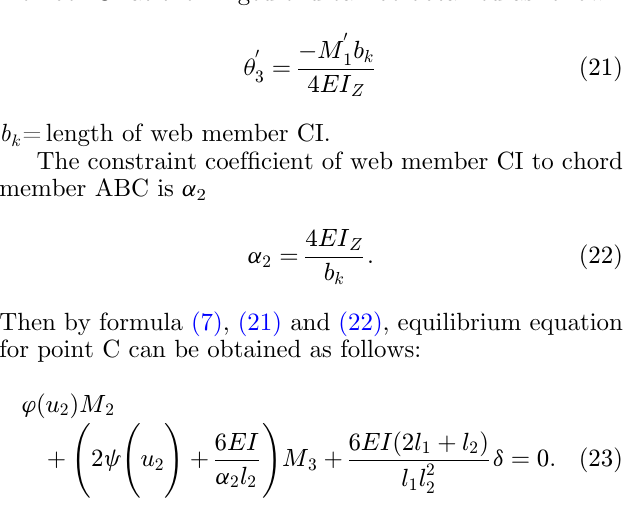
Table 2. The parameters of the cross-type truss boom with variable cross-section. Bottom length and